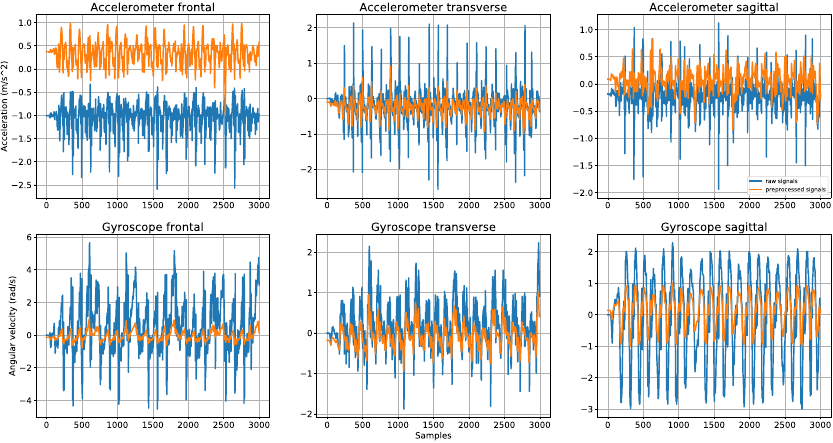
Figure 4. First 25 s of raw and the preprocessed data from the accelerometer at right thigh of one